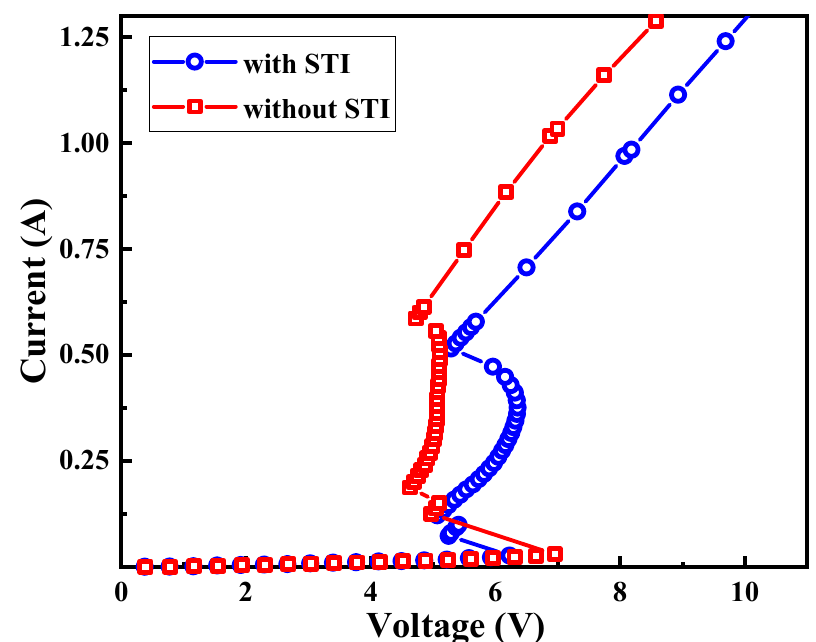
Figure 9. TCAD-simulated electrostatic potential distribution of PTBSCR (L = 0.5 μ m) when T1 is subject to a stress of I pulse = 75 μ A, T2 is grounded. The PTBSCR with ( a ) V G = 0 V, ( b ) V G = − 1 V, ( c ) V G = − 3 V, ( d ) V G = − 5 V.